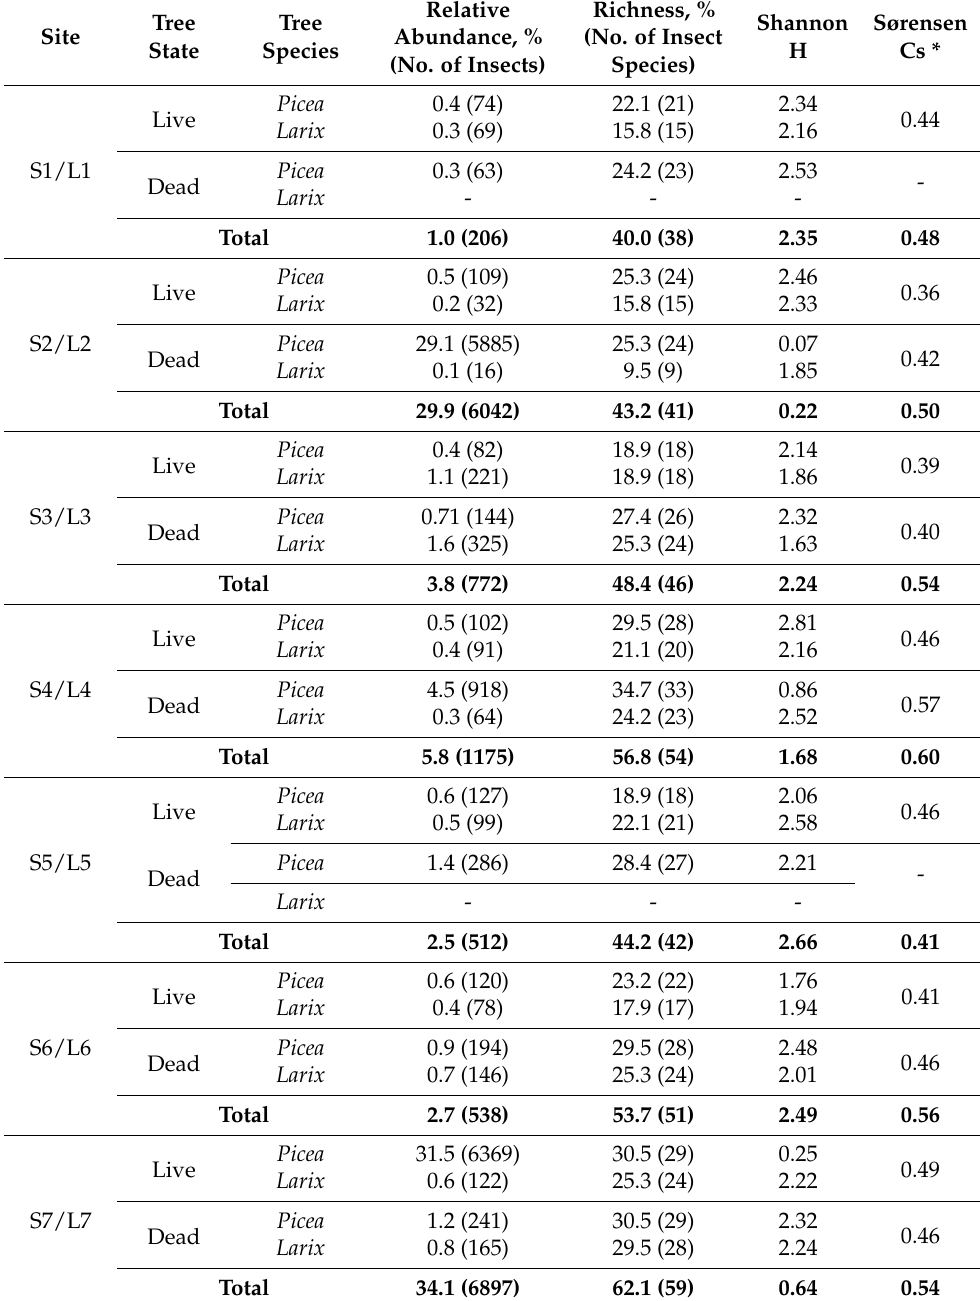
Table 2. Diversity of insects detected in sticky traps at different Picea abies and Larix sp. study